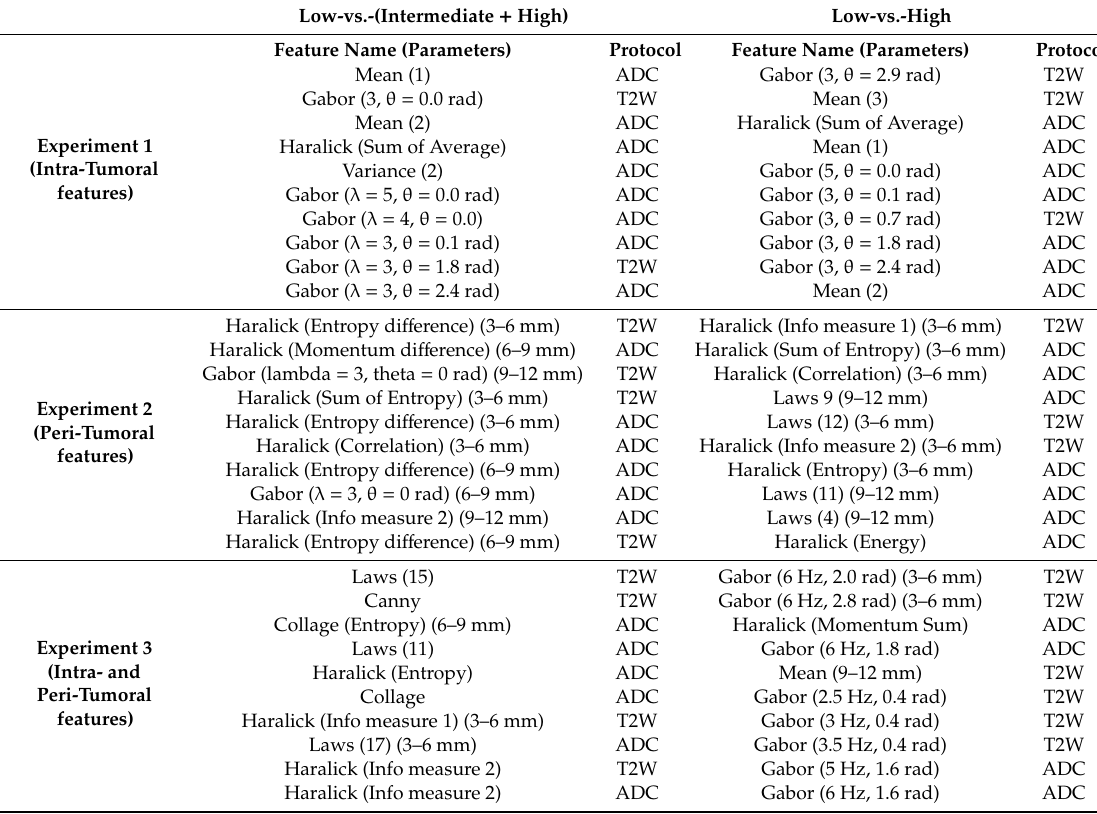
Figure 2. Receiver Operating Characteristic (ROC) analysis of Radiomic features derived from bi-parametric MRI for training ( left, n = 151) and validation ( right, n = 150) cohorts. AUCs increase significantly when intra-tumoral features are complemented with peri-tumoral features. AUCs of L-vs.-H are generally higher than those of L-vs.-I + H settings. Table 1. Results: The top 10 features from bi-parametric MRI for (a) Experiment 1: Intra-tumoral features alone, (b) Experiment 2: Peri-tumoral features alone, (c) Experiment 3: Intra-tumoral and Peri-tumoral features; in Low-versus-High, and Low-versus-(Intermediate + High) settings ( p -values < 0.01). Low-vs.-(Intermediate + High)